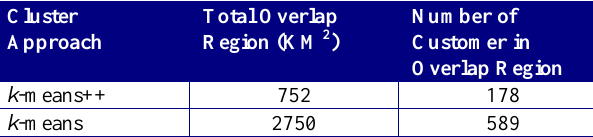
Figure 6. List of customer that cancel their purchase.